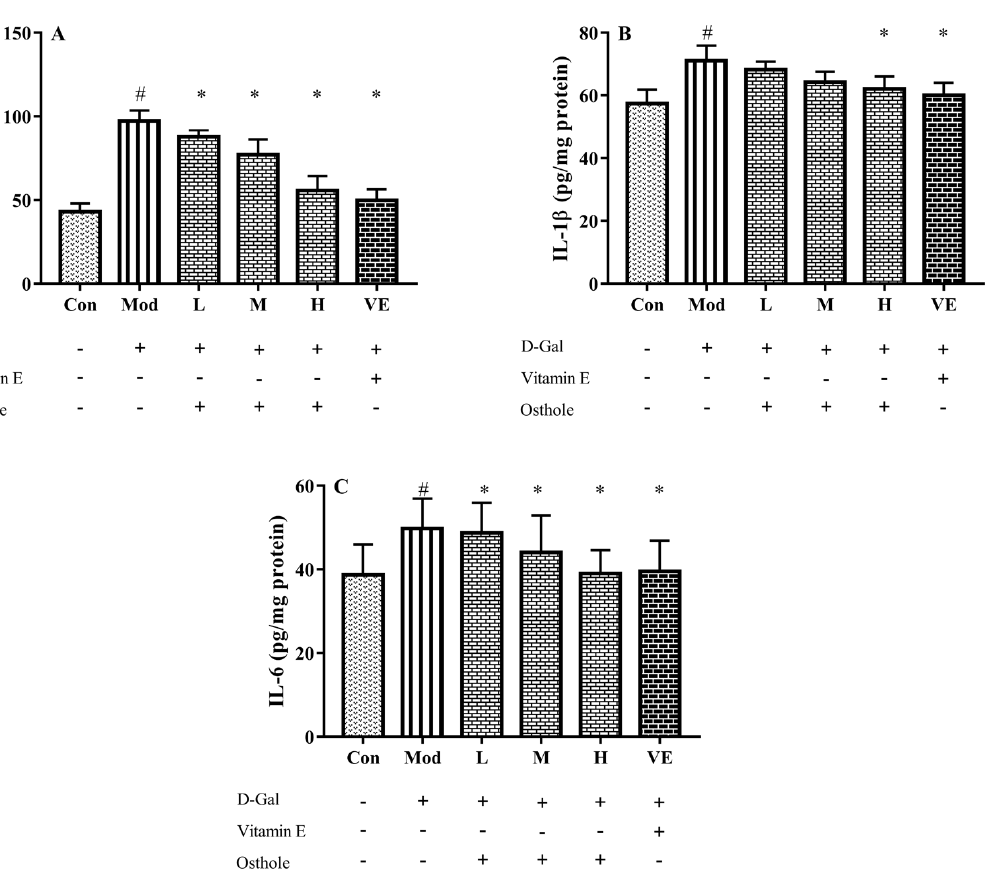
Figure 5. Effects of osthole on levels of ( A ) TNF-α, ( B ) IL-1β and ( C ) IL-6 in liver tissue of mouse D-Gal-induced aging model. #, p < 0.01 for comparison of model group with control group. *, p < 0.01 for comparison of experimental group with model group.